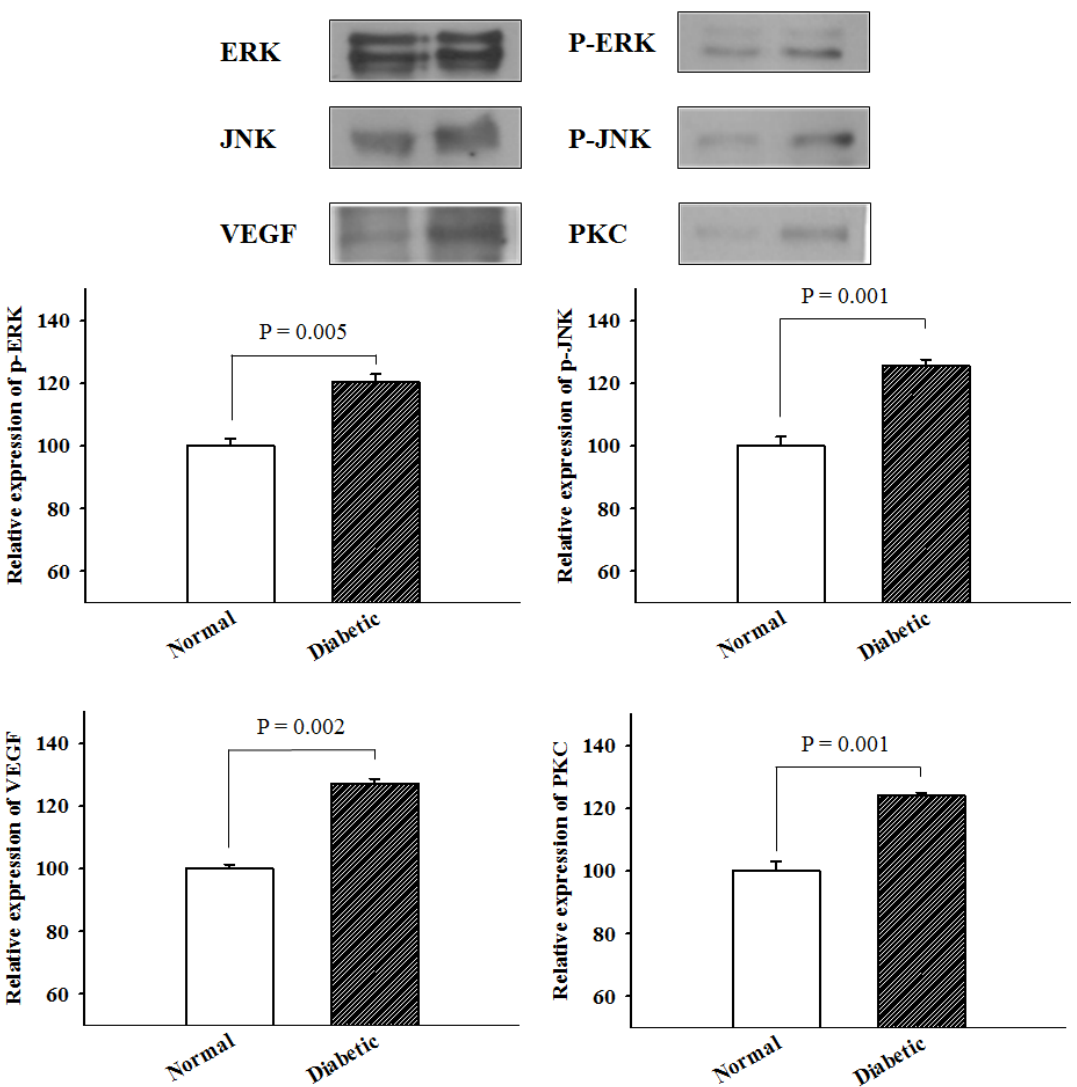
Figure 2. Cross-sectional images of the proximal (P), middle (M), and distal (D) ureter, with comparative graphs of normal and diabetic mouse ureteral smooth muscle thickness. P-ERK; phospho-extracellular signal regulated kinases; P-JNK: phospho-c-Jun N-terminal kinases; VEGF: vascular endothelial growth factor; PKC: protein kinase c. ERK: extracellular signal regulated kinases, JNK: c-Jun N-terminal